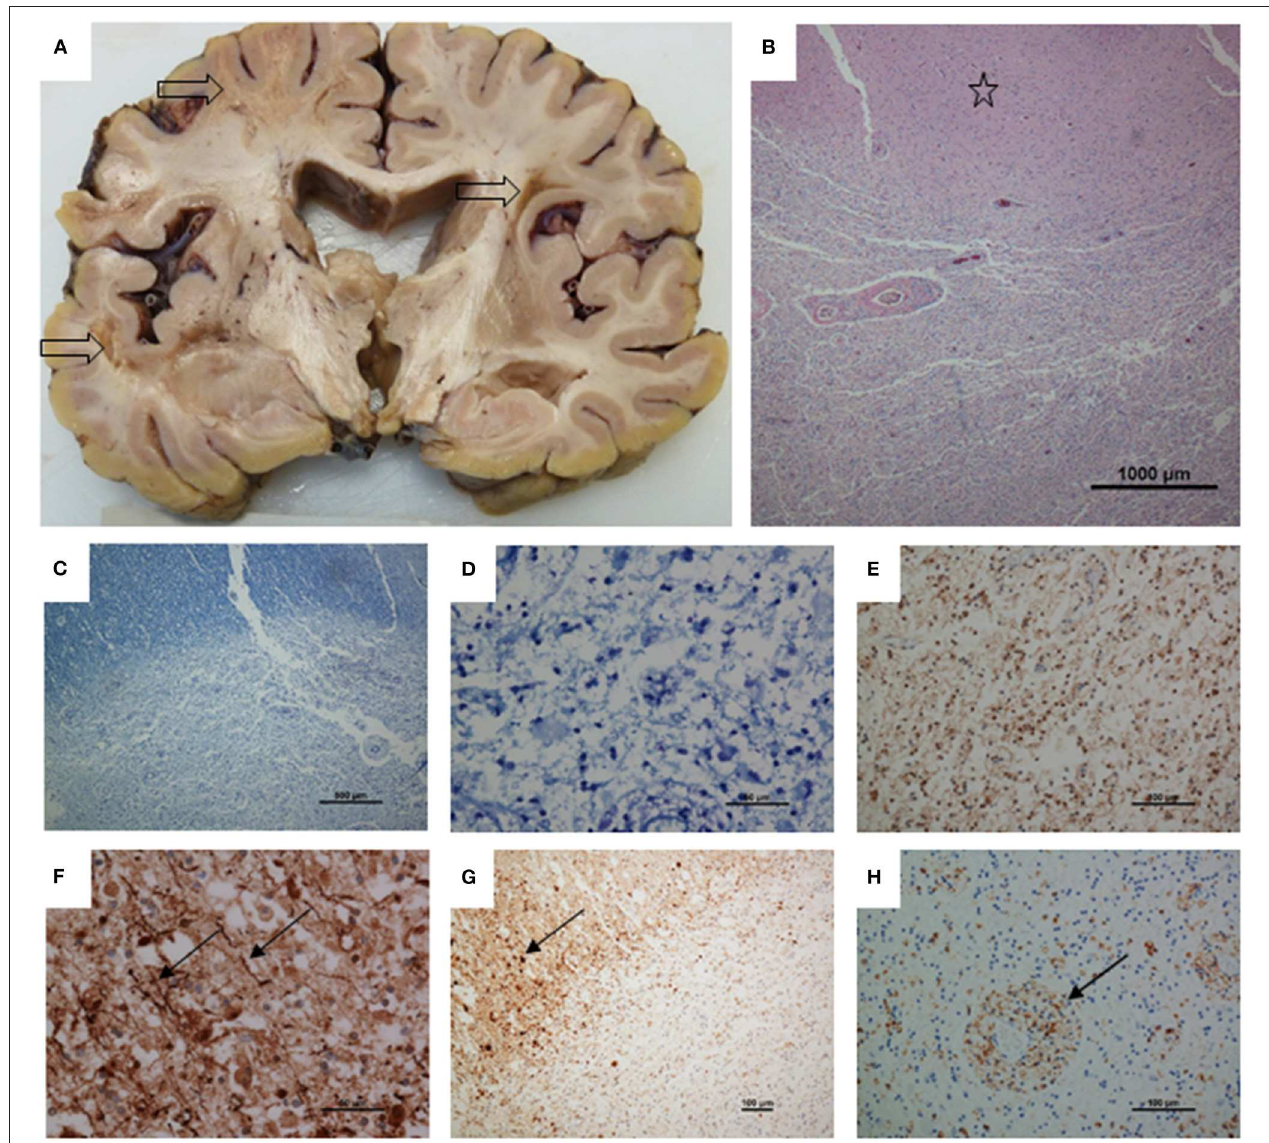
FIGURE 3 | Post-mortem neuropathology. (A) Coronal slice of cerebrum showing three irregular, cavitating white matter lesions (arrows). There is some dilatation ex vacuo of the ventricles, presumably secondary to white matter loss. (B) H and E stained section showing part of a lesion with preserved cortex above (star). (C) Luxol fast blue showing loss of myelin. (D) High power view of lesion stained with luxol fast blue shows total loss of myelin. (E) Neurofilament immunohistochemistry showing total axon loss in the center of a lesion. (F) Toward the lesion margin a few axons remain (arrows). (G) Up-regulation of amyloid precursor protein, upper left, with multiple axonal spheroids (arrow). (H) CD68 staining showing ameboid microglia, particularly in a perivascular location. Magnifications as shown on scale